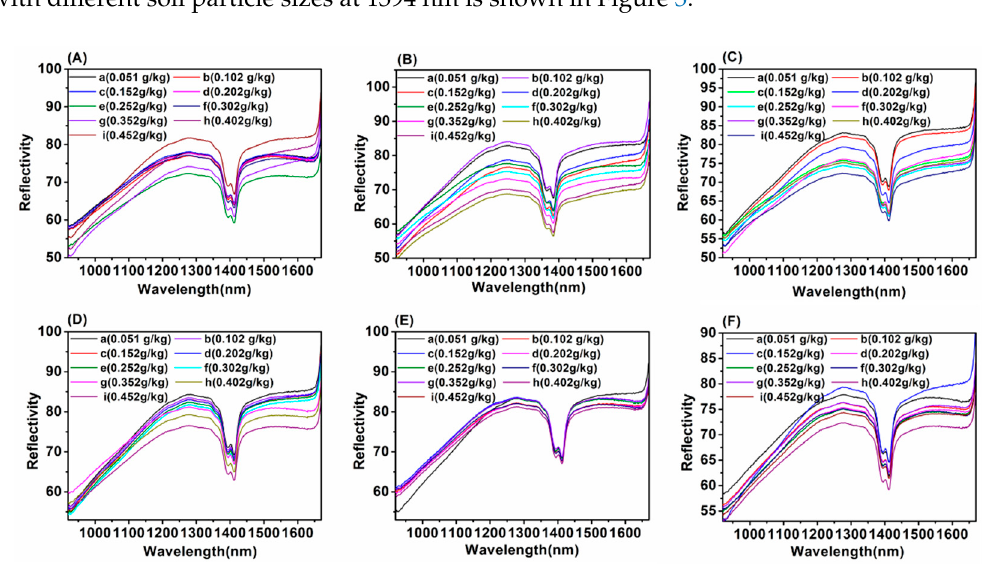
Figure 2. The average spectral reflectivity of soil with different soil particle sizes: ( A ) 1–2 mm; ( B ) 0.45–1 mm; ( C ) 0.28–0.45 mm; ( D ) 0.18–0.28 mm; ( E ) 0–0.18 mm; ( F ) 0–2 mm.